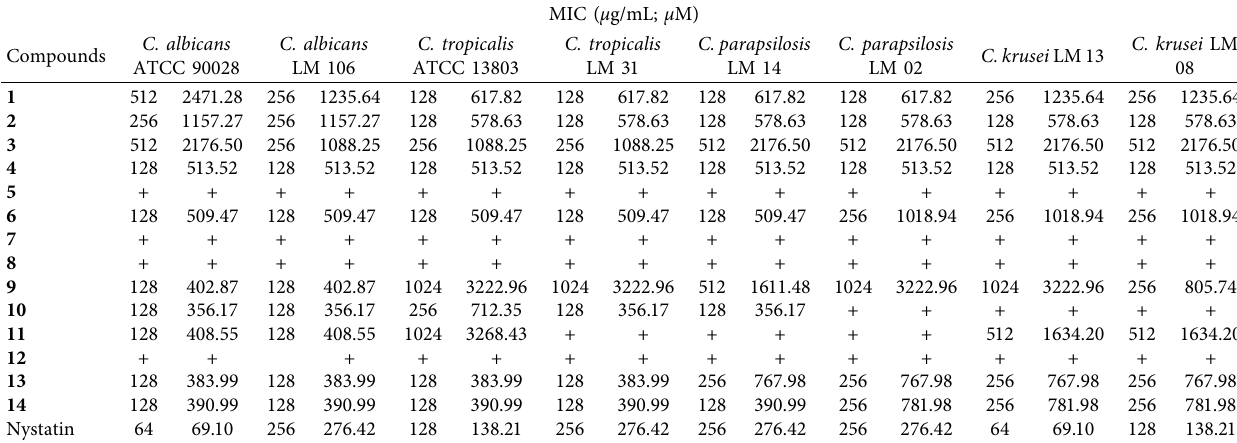
Table 1: Evaluation of MIC ( μ g/mL; μ M) of the esters derived from ( E )-2-nitrocinnamic acid in the microdilution broth